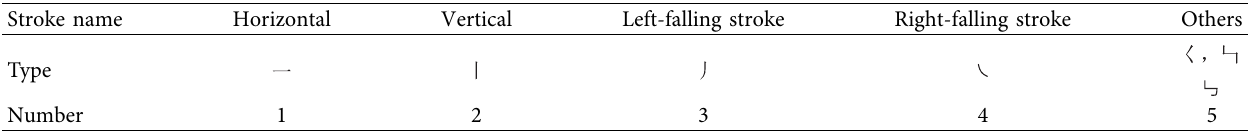
Table 1: Stroke type and